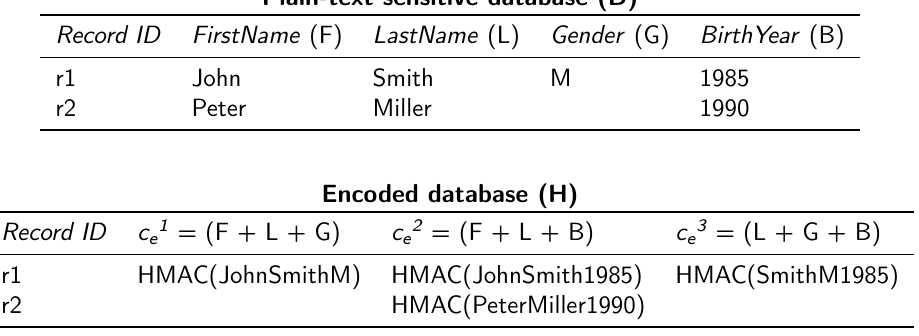
Figure 1: An example encoding process assuming three attribute combinations (match-keys) where | mk refers to the plain-text database attributes before encoding and the bottom table refers to the generated match-key values using HMAC [7]. Note that no match-key value (hash-code) is generated if a match-key has a missing attribute